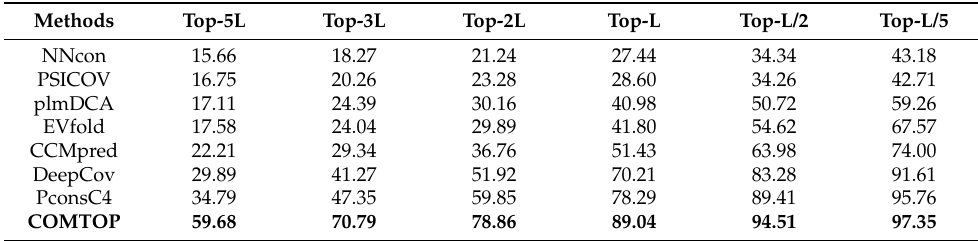
Table 2. The prediction accuracies for COMTOP and the seven individual methods (PconsC4, DeepCov, CCMpred, EVfold, plmDCA, PSICOV, and NNcon) on the 239 non-redundant proteins.